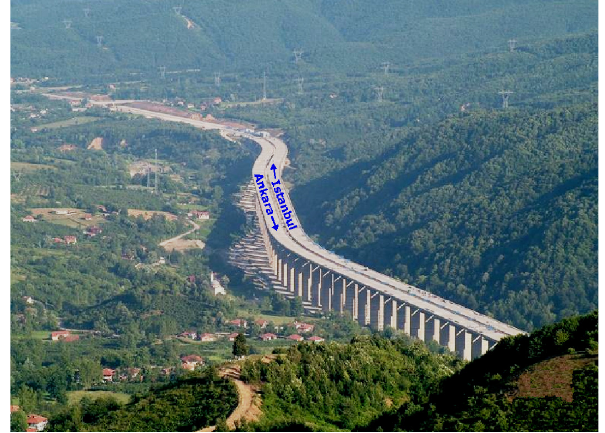
Figure 1: North Anatolian Fault (NAF), the main highway from Ankara to Istanbul (TEM) and the location of the Bolu Viaducts (GMT software, Wessel and Smith, 1991, 1995, 1998)